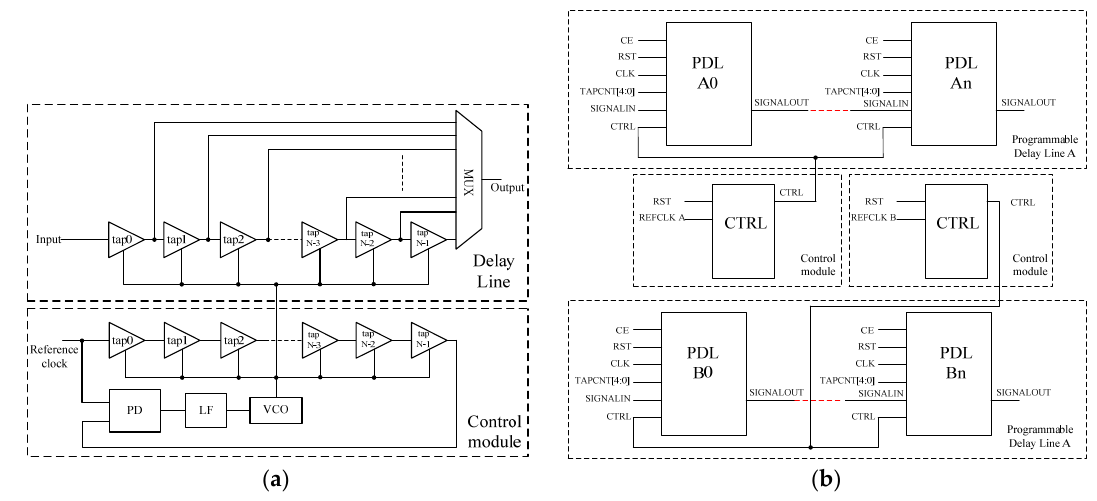
Figure 3. Schematic diagram of a programmable delay line. ( a ) Schematic diagram of a PDL (programmable delay line); ( b ) Schematic diagram of PDL delay lines.